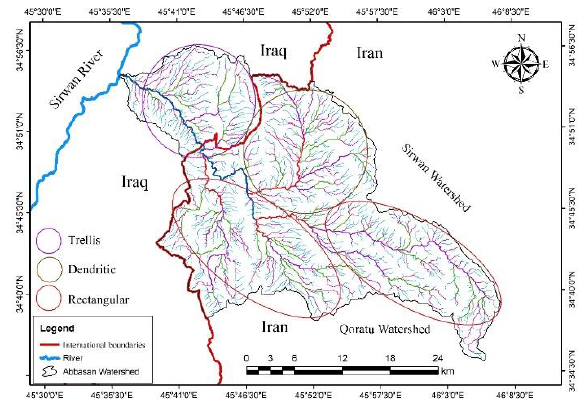
Figure 4: Patterns of drainage basin of Abbasan